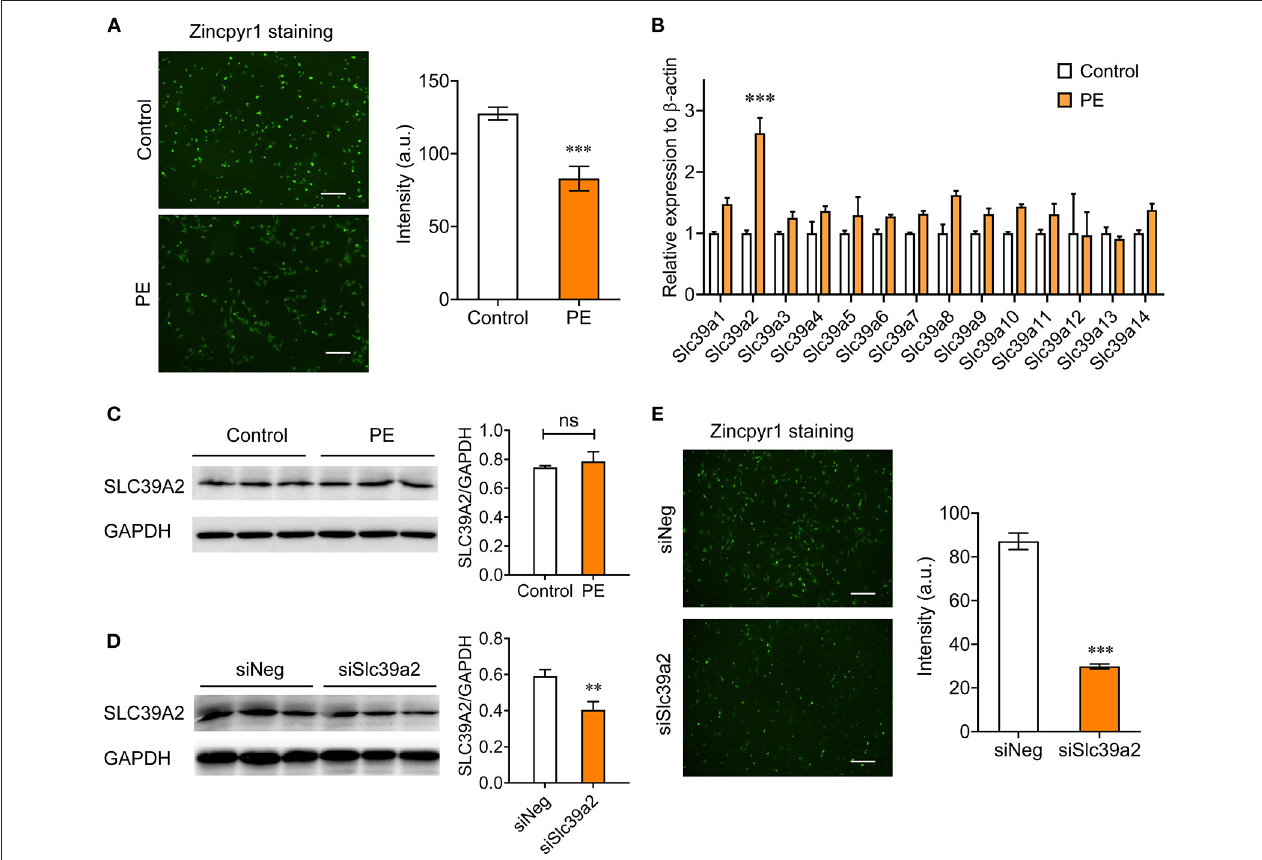
FIGURE 1 | Abnormal expression of Slc39a2 is associated with zinc depletion in phenylephrine (PE)-treated cardiomyocytes. (A) Representative images (left) and quantification data (right) of Zincpyr1 staining in neonatal rat ventricular myocytes (NRVMs) with or without phenylephrine (PE; 50 µ M) treatment. Scale bar, 200 µ m. *** P < 0.001 vs. Control. n = 3. (B) qRT-PCR analysis for Slc39a family members (1-14) in PE-induced cardiomyocyte hypertrophy. *** P < 0.001 vs. Control. n = 3. (C) Immunoblots (left) and quantification data (right) of SLC39A2 in NRVMs with or without PE treatment. n = 3. (D) Validation of knockdown efficacy of siSlc39a2. ** P < 0.01 vs. siNeg (negative control siRNA). n = 3. (E) Impact of Slc39a2 knockdown on Zinc contents in NRVMs. *** P < 0.001 vs. siNeg. n =